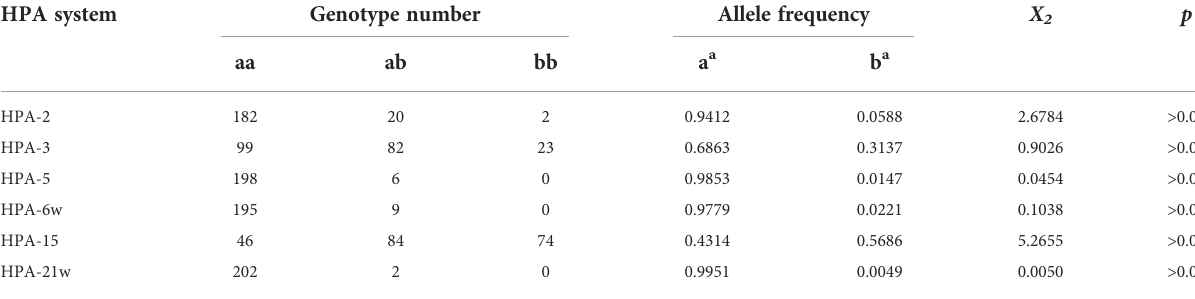
TABLE 2 The HPA genotypes and allele frequencies in the Chinese platelet blood donors ( n = 204). HPA